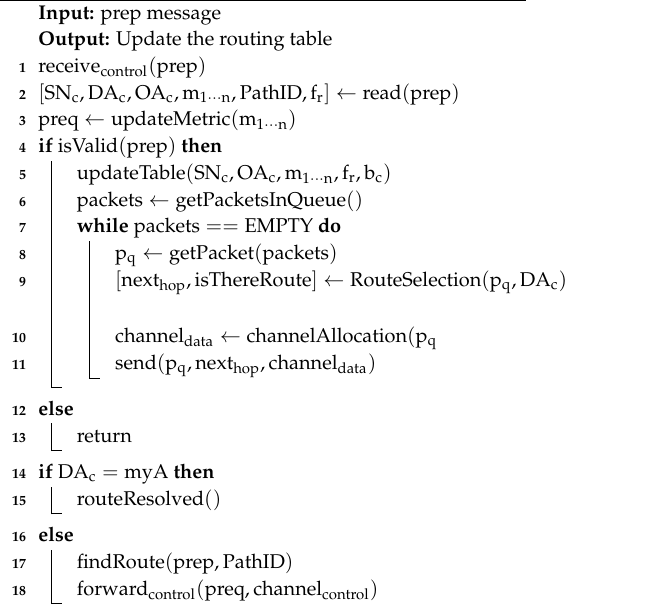
Algorithm 2: PREP element process and